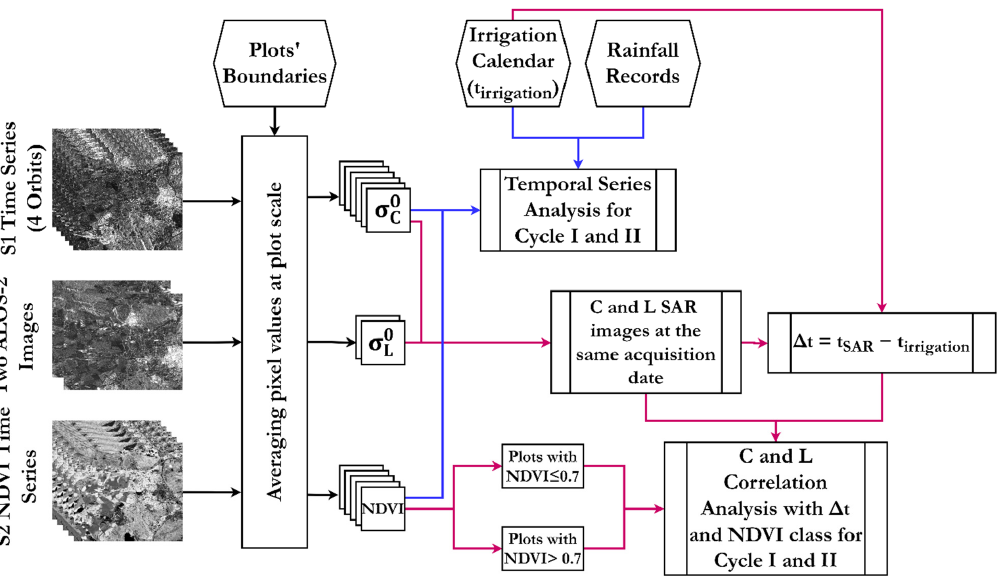
Figure 4. Flowchart of the performed comparative analysis. Arrows in blue represent the time series analysis. Arrows in magenta represent the C–L correlation analysis with ∆t values.